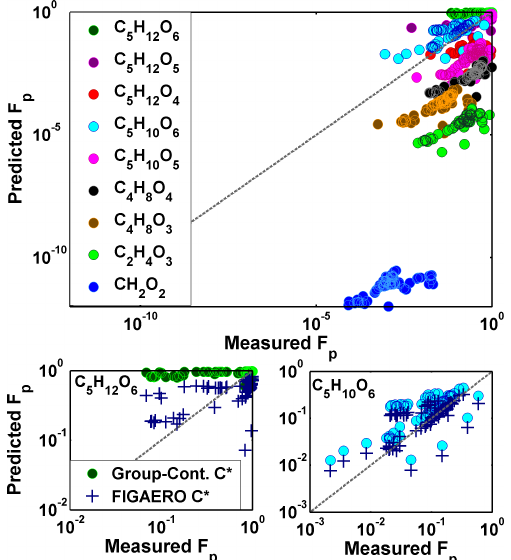
Figure 5. Top: predicted versus measured fraction in the particle phase ( F p ). Predicted F p is obtained from Eq. (1) where C ∗ s were calculated with the EVAPORATION group-contribution method (Compernolle et al., 2011) labeled as “Group-Cont. C ∗ ” in the bot- tom panels. Measured F p is the direct measurement from the FI- GAERO. Bottom: the F p can also be predicted based on the cali- brated FIGAERO temperature axis as discussed in the methods and is shown as the predicted F p here. Agreement can be reached for two representative compounds where the F p is over and correctly predicted (left and right,